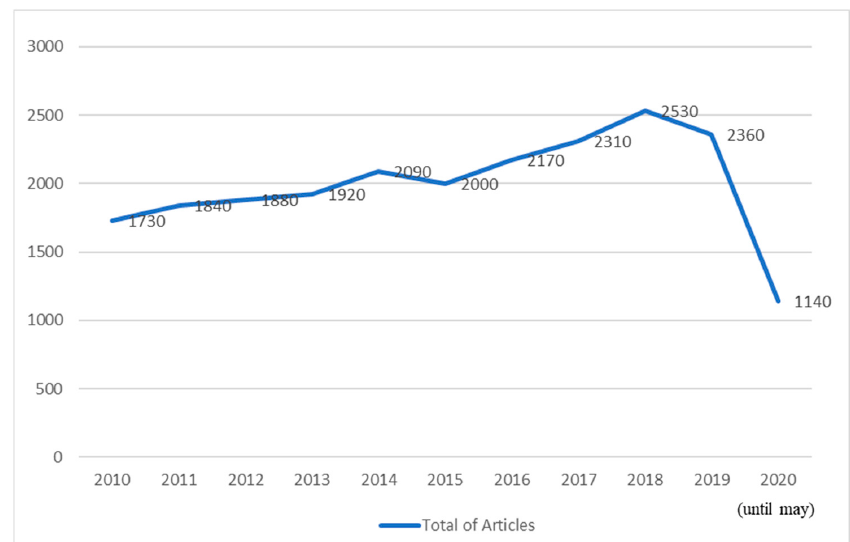
Figure 4. Articles Percentage by Publication Type.